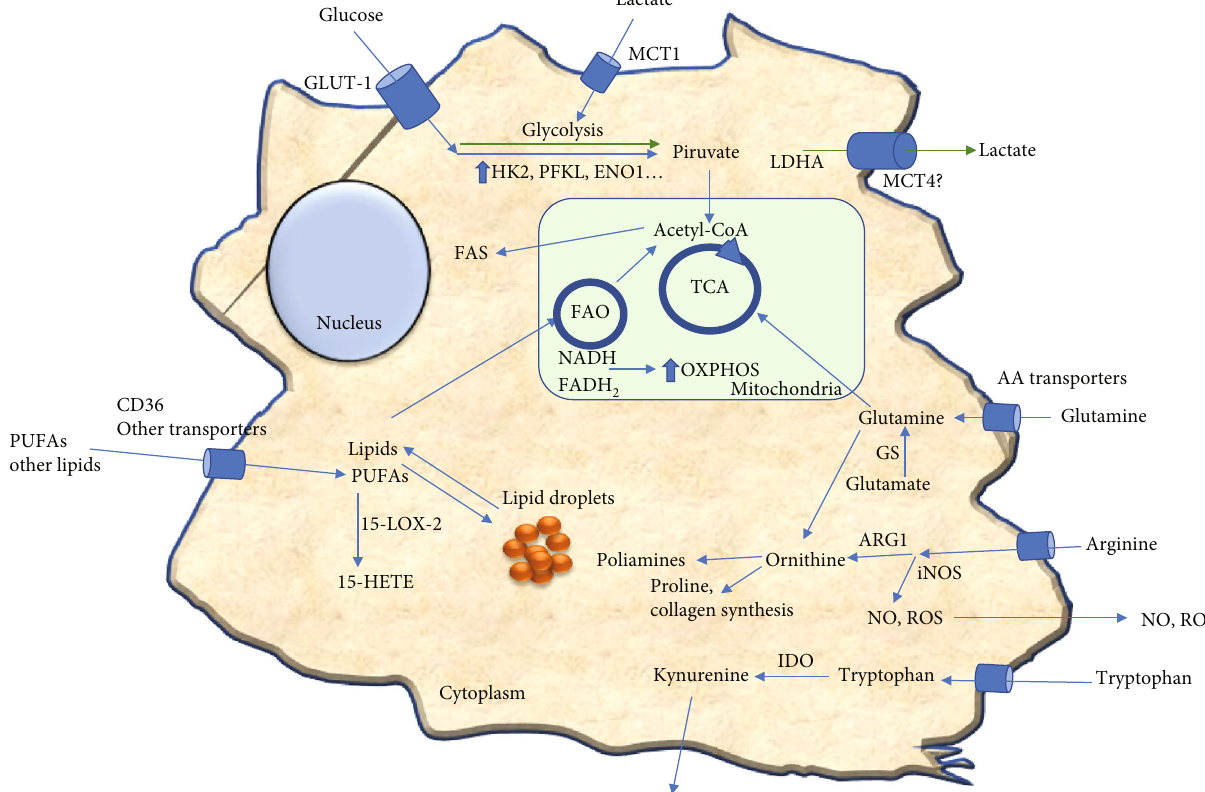
Figure 1: Metabolic features of tumor-associated macrophages (TAMs) may dynamically adjust their metabolism within the tumor microenvironment. Extracellular lactate can stimulate glycolysis by creating a pseudohypoxic milieu that may increase lactate production and secretion. Also, TAMs utilize glycolysis, TCA, and OXPHOS to increment the rate of bioenergetic production. TAMs exhibit increased glutamine, arginine, and tryptophan metabolism, increasing energy production, collagen synthesis, and immunosuppressive functions. Furthermore, depending on the TAM stage, lipid metabolism is also altered due to lipid uptake and storage may increase or lipids may be derived towards FAO and participate in TCA and OXPHOS. Moreover, active glycolysis may connect with F.A.S. by increasing acetyl-CoA production; for further details, see the text. TCA: tricarboxylic acid cycle; OXPHOS: oxidative